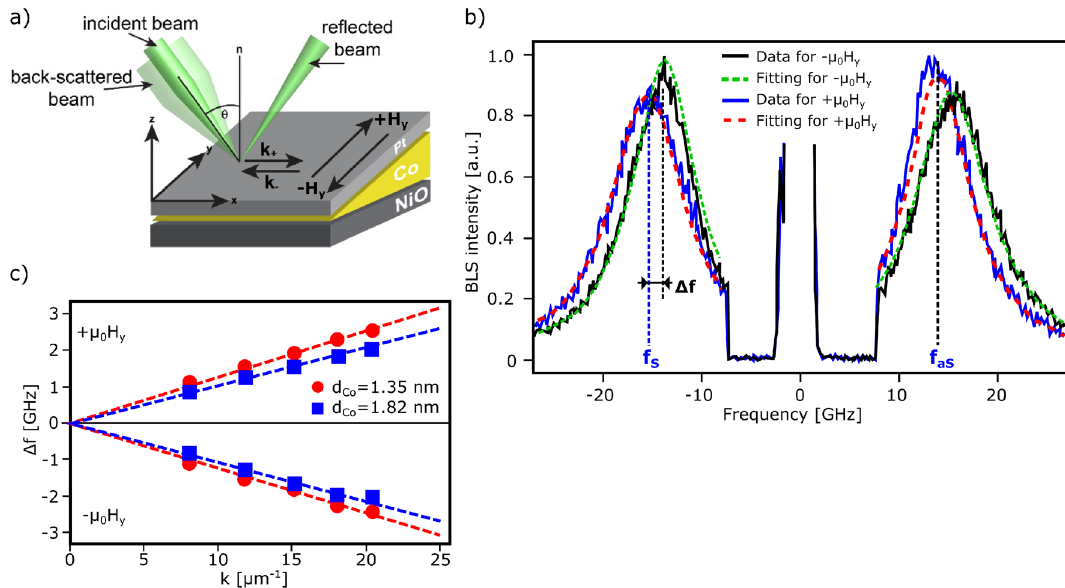
Figure 4. Results of BLS measurements. ( a ) BLS schematic for Damon-Eshbach configuration: magnetic field is applied in the sample plane along y; xz—plane of incidence, θ —incidence angle; studied SW wave vector k is along x; ( b ) BLS spectrum acquired for k = 11.81 µm −1 , µ 0 H y = − 0.4 T (black curve) and µ 0 H y = + 0.4 T (blue curve) for d Co = 1.35 nm with the definition of the characteristic parameters: the Stokes frequency f S , the anti- Stokes frequency f aS , frequency difference Δf ; the dashed red (green) lines represent the peaks fittings to the positive (negative) in-plane field. ( c ) Δf (k) dependence measured for positive (+ µ 0 H y ) and negative ( − µ 0 H y ) in-plane fields for d Co = 1.35 nm (red dots) and 1.82 nm (blue squares); red (blue) dashed lines—linear fits passing through (0;0) for d Co = 1.35 nm (1.82 nm). The error of the Δf (k) is 0.05 GHz and 0.07 GHz for d Co = 1.35 and 1.82 nm,